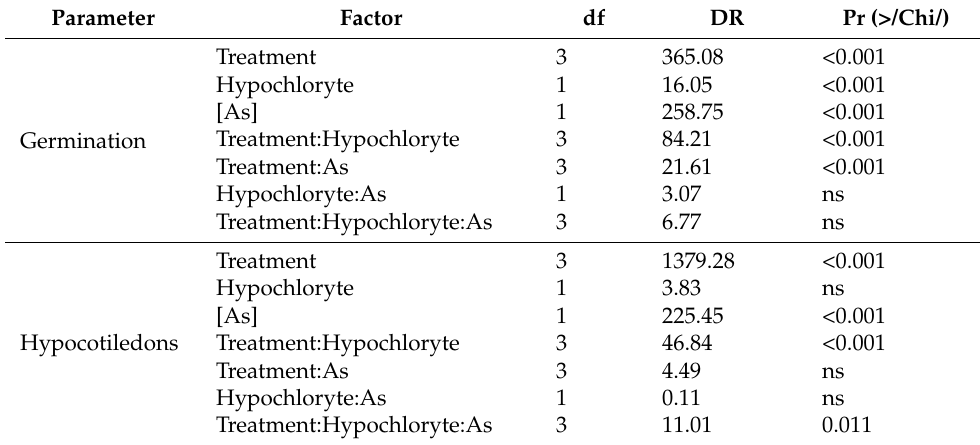
Table 2. GLM analyses to test the effect of arsenic and hypochlorite washes on germination process of functional gnotobiotic J. montana obtained by different levels of sterilization (T1, T1, T3 and T4). Degrees of freedom (df), Deviance Residual (DR) and the probability associated to the estimation (Pr). The zero concentration of arsenate is the value of